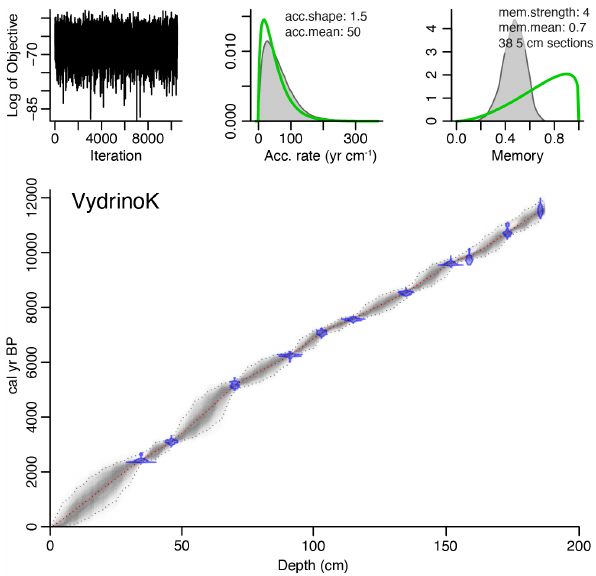
Figure 2. “Bacon” age–depth model (Blaauw and Christen, 2011) for Vydrino box (CON01–605–05) and piston cores (CON01–605– 03) of radiocarbon AMS dates calibrated using IntCal20 radiocar- bon calibration curve (Reimer et al.,